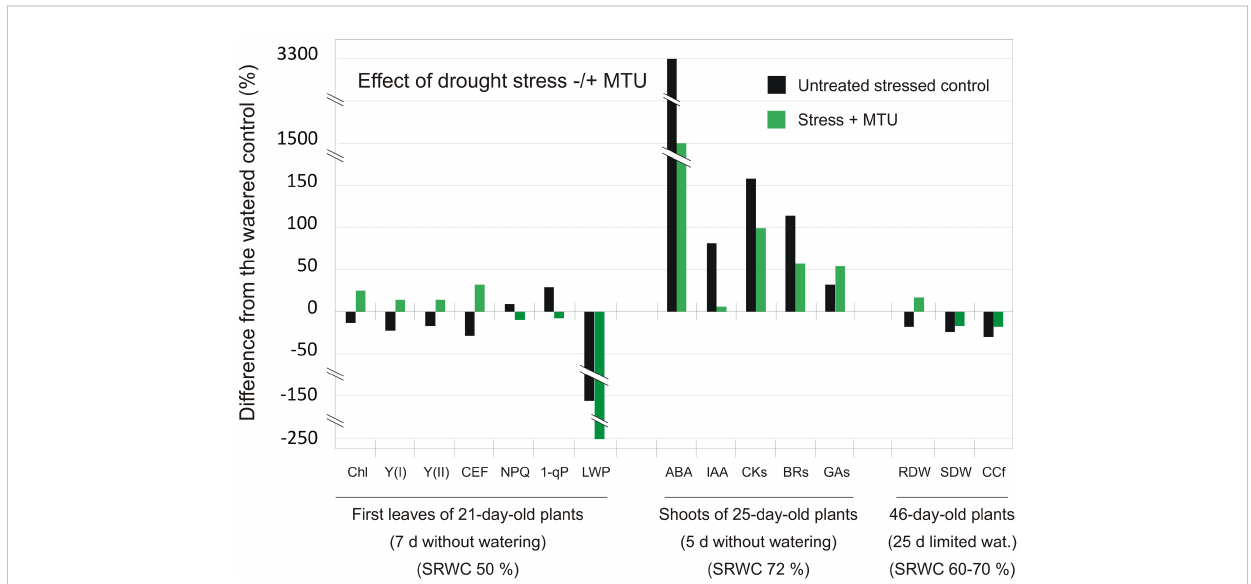
FIGURE 6 The comparison of relative differences in individual parameters and phytohormone content induced by drought in control plants and MTU-treated plants relative to the watered control plants. Chl – chlorophyll content; Y(I) and Y(II) – the effective quantum yield of PSI and PSII photochemistry in the light-adapted state; CEF, cyclic electron fl ow around PSI; NPQ, non-photochemical quenching; 1-qP, a fraction of reduced PQ pool; LWP – leaf water potential; ABA, abscisic acid; IAA, indole-3-acetic acid; CKs, cytokinins; BRs, brassinosteroids; Gas, gibberellins; RDW, root dry weight; SDW, shoot dry weight; CCf, chlorophyll coef fi cient (de fi ned as the product of the shoot dry weight (g) and the SPAD value); d, days; wat., watering; SRWC, soil relative water